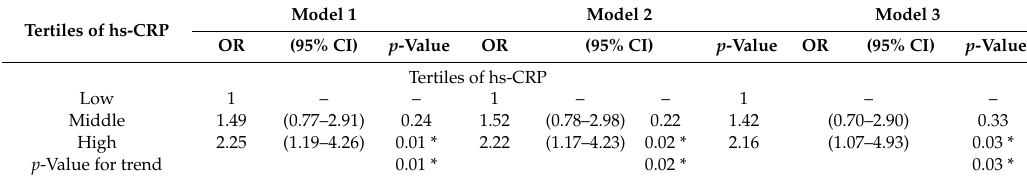
Table 3. Associations between tertiles of hs-CRP and renal impairment.